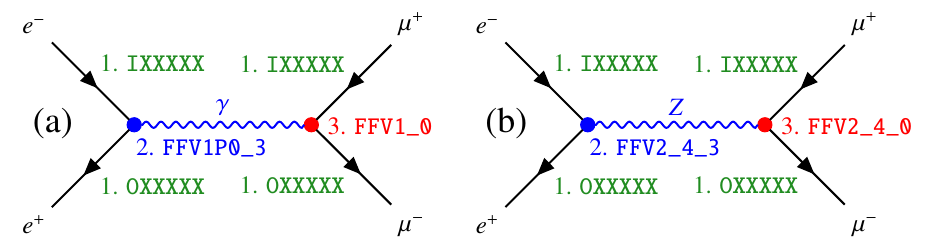
µ + µ − at tree level: (a) photon exchange and Figure 1. The two Feynman diagrams contributing to e + e − → (b) Z exchange. The routines called by MG5aMC to compute the ME for each event are also indicated. First, the wavefunctions of the four external fermions are computed using IXXXXX and OXXXXX , given their momenta and helicities. This is only done once, as the result is the same for both diagrams. Next, the wavefunctions of the γ and Z propagators in the two diagrams are computed from their coupling to the initial state electrons, using FFV1P0_3 and FFV2_4_3 . Finally, the transition amplitudes are computed from the boson couplings to the final state muons in the two diagrams, using FFV1_0 and FFV2_4_0 . The two amplitudes are added to each other, their sum is squared, and the result is averaged over all valid helicity combinations to obtain the matrix element. Each of the four fermions has two possible helicity states, therefore there are in principle sixteen helicity combinations; however, as the γ and Z are vector bosons with spin 1, only four of those are allowed. Drawn with TikZ-Feynman